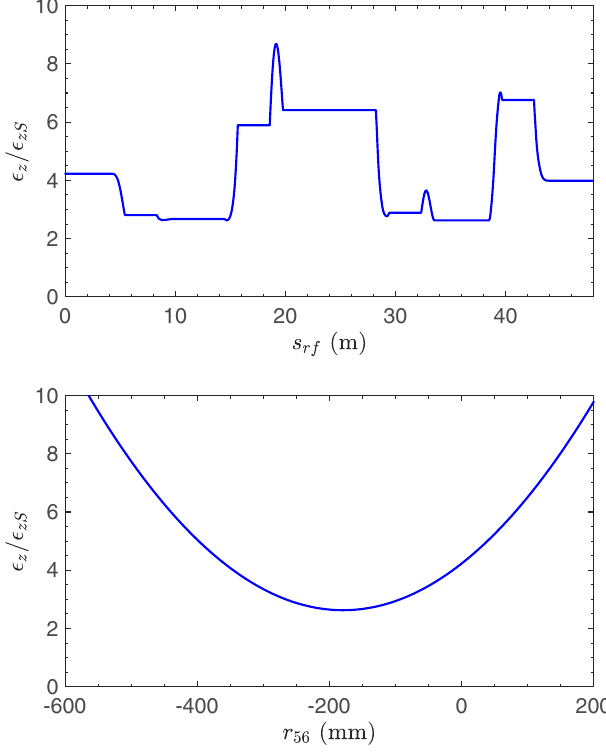
FIG. 3. The emittance ratio ϵ z as a function of the rf place s ϵ z S (top) and the r 56 artificially inserted in front of the rf whose ¼ 0 m (bottom). The lattice optics and location is fixed at s rf related parameters are shown in Fig. 1 and Table I. The rf voltage ¼ 80 applied is V rf